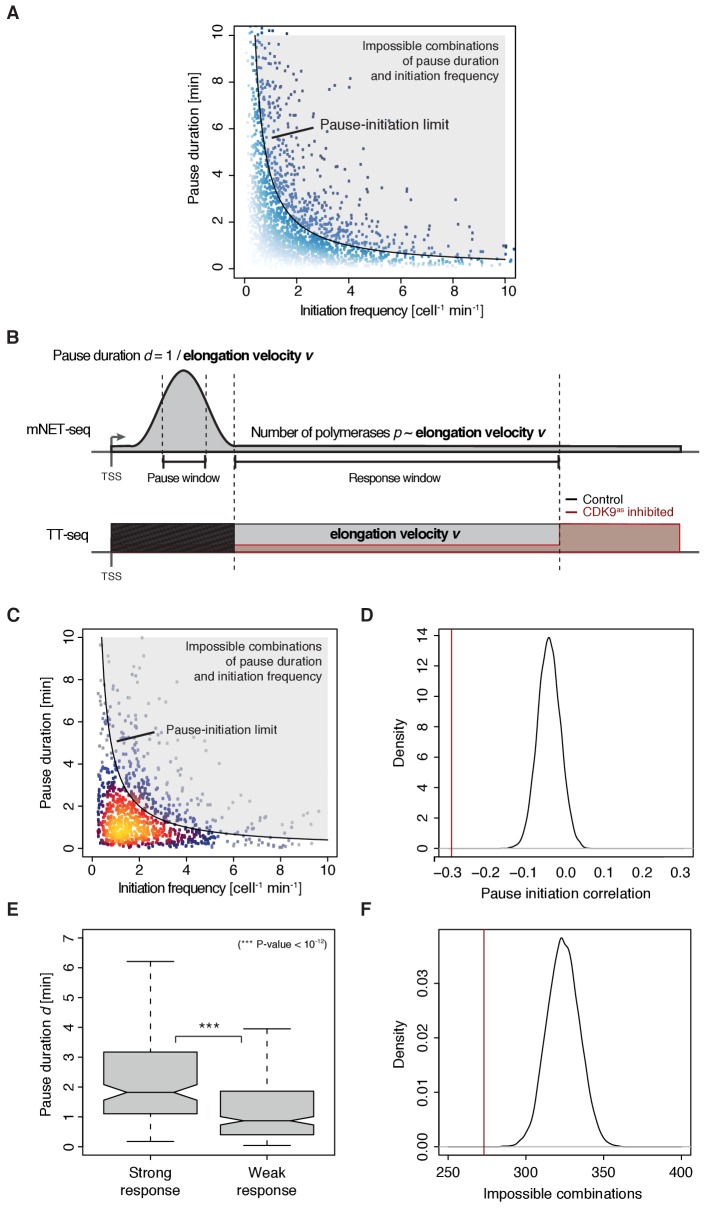
Verification of anti-correlation between initiation frequency I and pause duration d including ‘pause-initiation limit’.(A) Scatter plot comparing the initiation frequency [cell−1min−1] against the pause duration [min] for 2135 common TUs with color encoding according to mNETseq signal strength (weak in white to strong in blue). The grey shaded area depicts impossible combinations of I and d according to published kinetic theory (Ehrensberger et al., 2013) and assuming that steric hindrance occurs below a distance of 50 bp between the active sites of the initiating Pol II and the paused Pol II. (B) Schematic representation of polymerase flow in the promoter-proximal region. The number of polymerases in a region of interest (mNET-seq signal, top) corresponds to the average elongation velocity v in that region. The width of the response window (TT-seq signal, bottom) informs on Pol II elongation velocity v. The pause duration d^ can be derived (without the initiation frequency I) as the reciprocal of v in the pause window. The elongation velocity v in the pause window relates directly to v in the response window which can be adjusted to the elongation velocity obtained from CDK9 inhibition (Materials and methods). (C) Scatter plot revealing an anti-correlation between the initiation frequency I [cell−1min−1] and the pause duration d^ [min] for 974 common TUs with color-coded density estimation (Spearman correlation coefficient −0.3). The grey shaded area depicts impossible combinations of I and d^ according to published kinetic theory (Ehrensberger et al., 2013). (D) Density showing the spearman correlation coefficient of pause duration d^ and initiation frequency I for repeated randomly shuffled mNET-seq signal assignment to TUs. Original spearman correlation coefficient is indicated with a red line. (E) Distributions of gene-wise pause duration d^ [min] for TUs with a CDK9 response ratio >75% quantile (155 TUs) and TUs with a response ratio <25% quantile (271 TUs). (F) Density showing the number of impossible combinations of pause duration d^ and initiation frequency I (above pause-initiation limit) for repeated randomly shuffled mNET-seq signal assignment to TUs. Original observation is indicated with a red line.